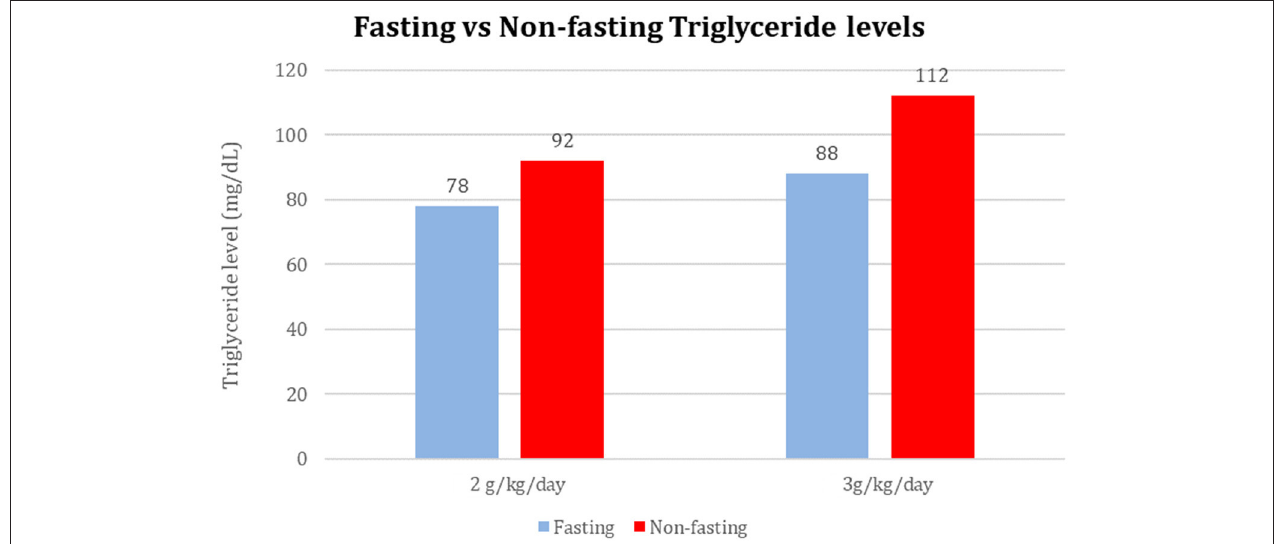
FIGURE 1 | Mean fasting and non-fasting serum TG levels in infants receiving 2 and 3g/kg/day.